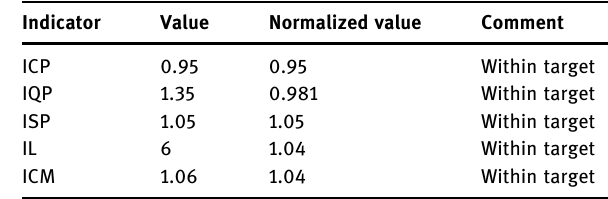
Table 8: Performance pairwise comparison table